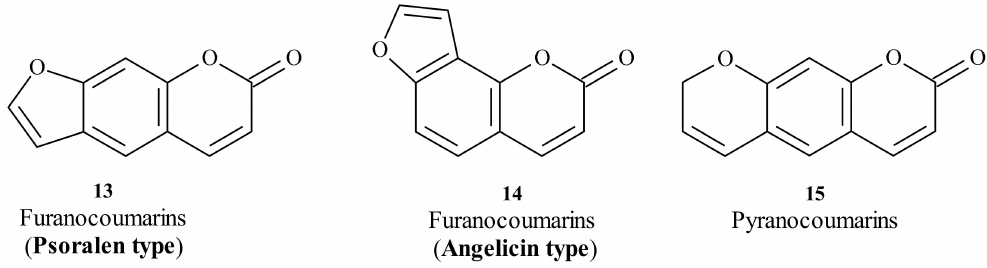
Figure 7. Furanocoumarins and